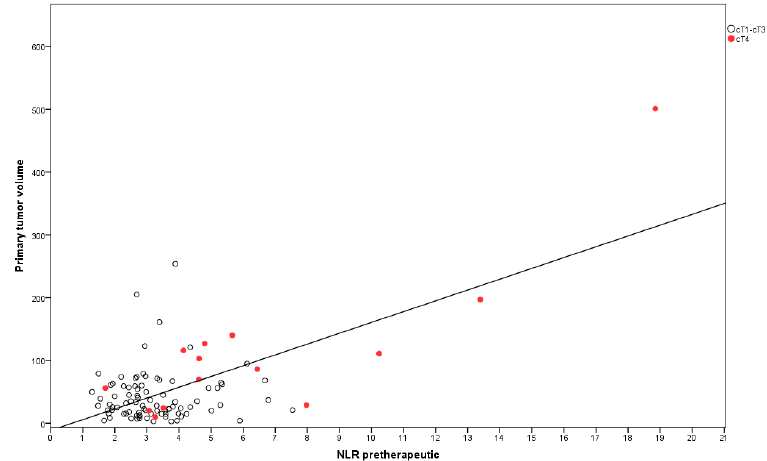
Figure 2. Dot plot showing a correlation between primary tumor volume and NLR.